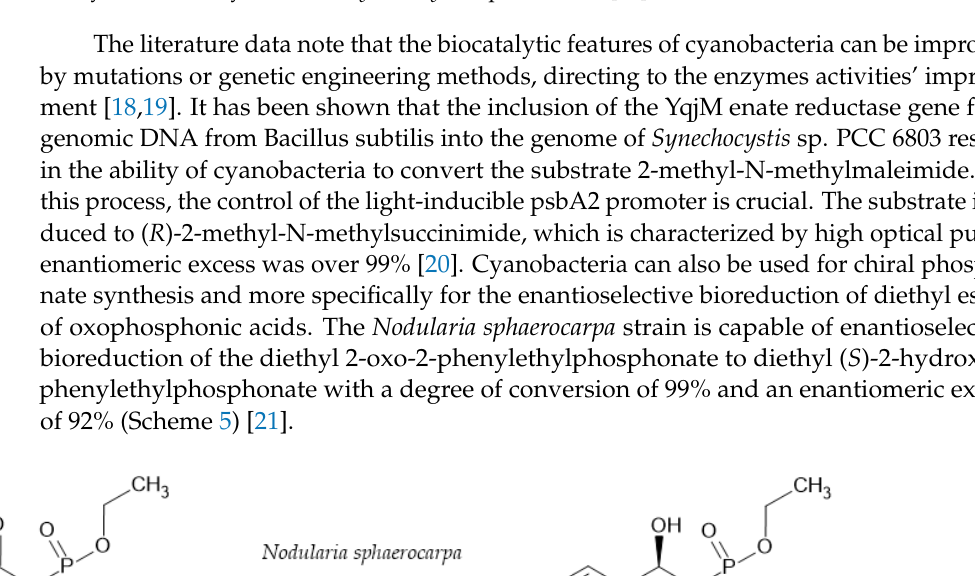
Scheme 4. The biotransformation process of (+)-camphorquinone to (-)-(3 S )-exo-hydroxycamphor with yield of 94% by the strain Synechosystis sp. PCC6803